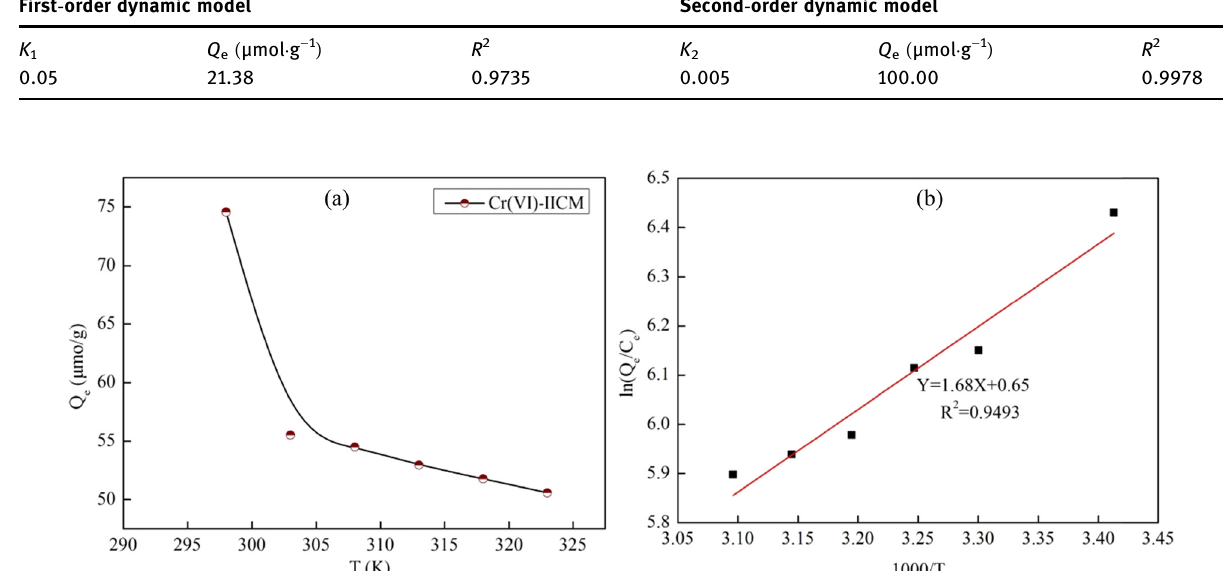
Figure 6: Temperature dependence of the adsorption quantity of Cr ( VI )- IICM ( a ) , thermodynamic fi tting curve ( b )